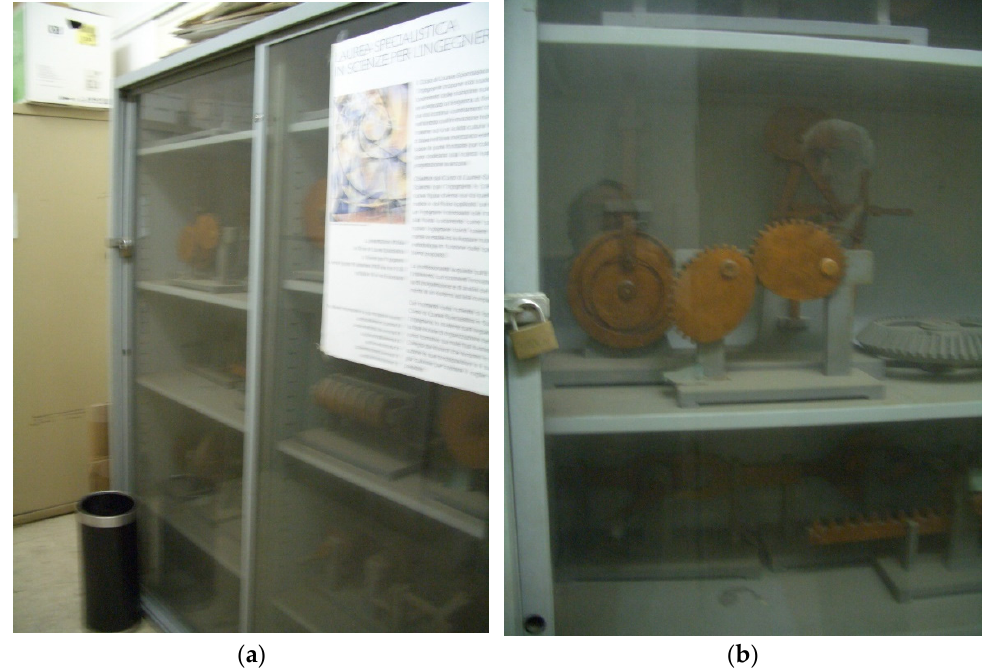
Figure 9. Frame of today’s storage of wood models at the Department of Mechanics and Aeronautics in Rome: ( a ) the storage wardrobe; ( b ) zoomed view of the storage within the wardrobe.